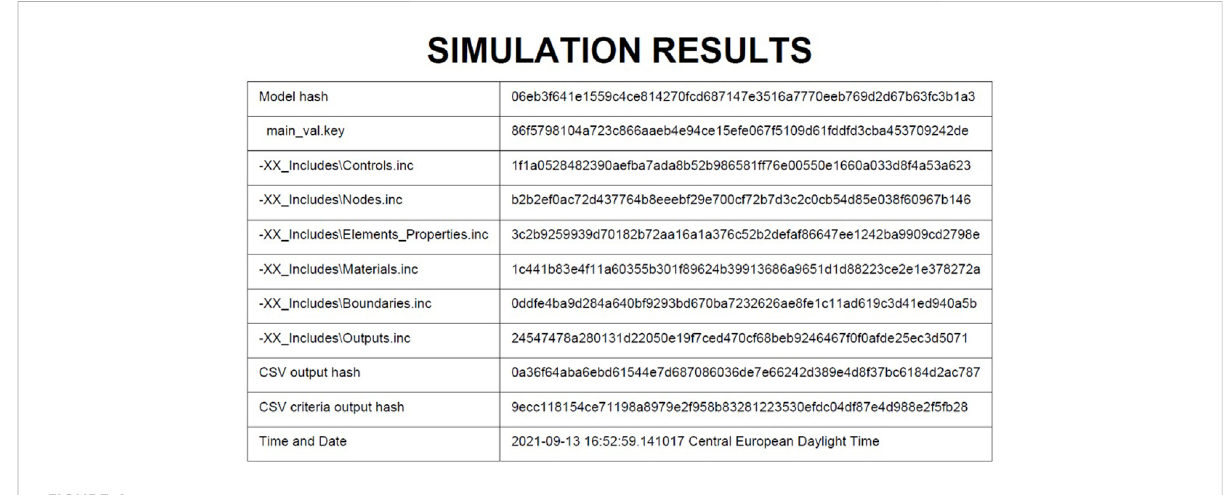
FIGURE 4 Exemplary structure of the simulation report based on the “ cube ” example of Figure 2.